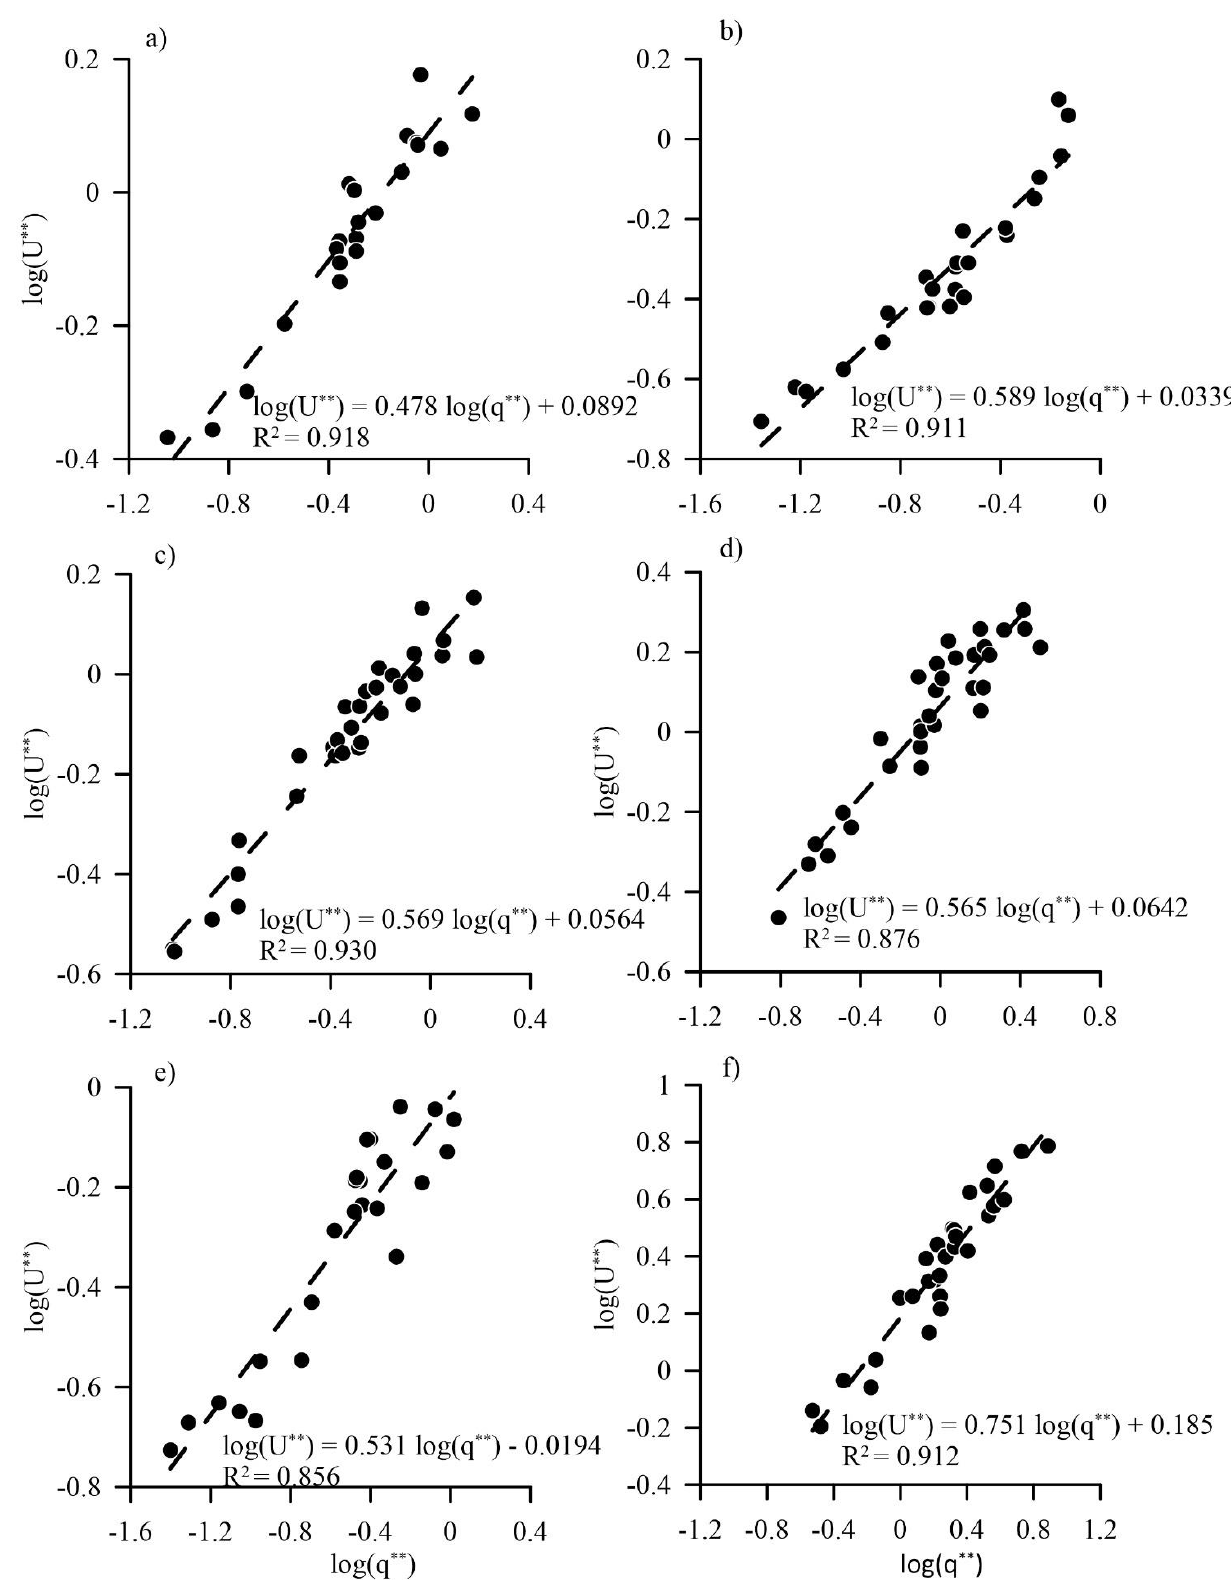
Figure 3. Linear regression of Equation (3): ( a ) Cascade 1; ( b ) Cascade 2; ( c ) Cascade 3; ( d ) Step-pool 1; ( e ) Step-pool 2; ( f ) Plane-bed .